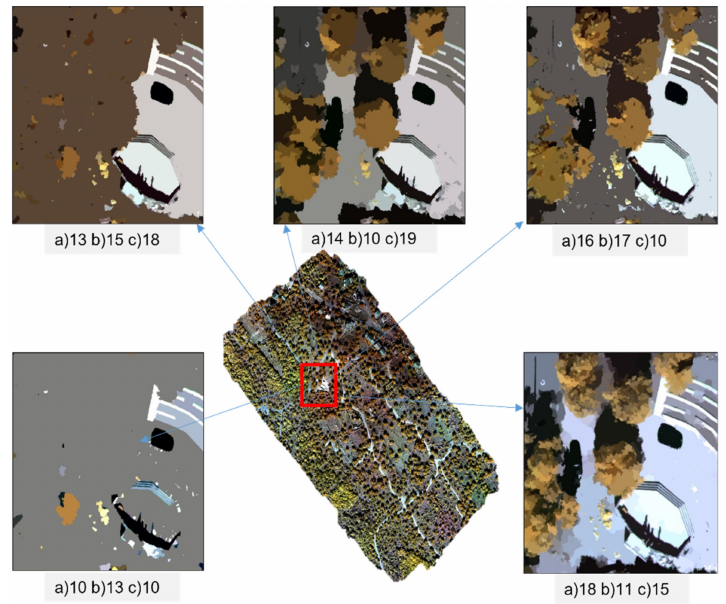
Figure 4. Differences between various segmented models: ( a ) spectral detail; ( b ) spatial detail; ( c ) minimum segment size.